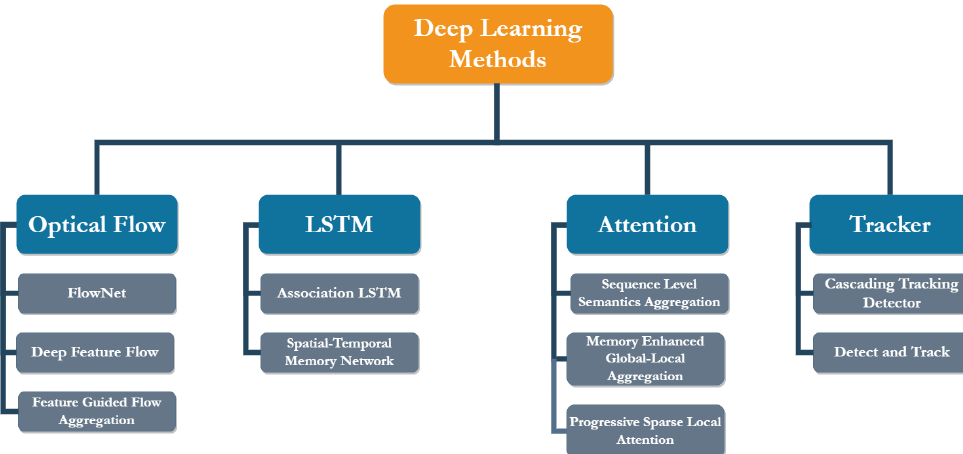
Figure 2. Overview of deep learning-based video object detection methods. The surveyed works have been categorized under the corresponding